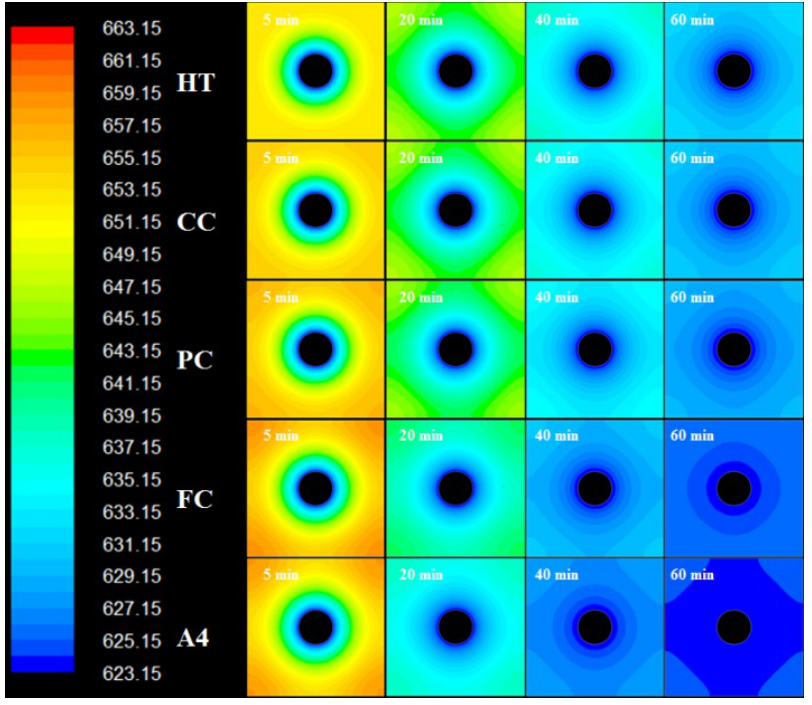
, discharge phase. tot